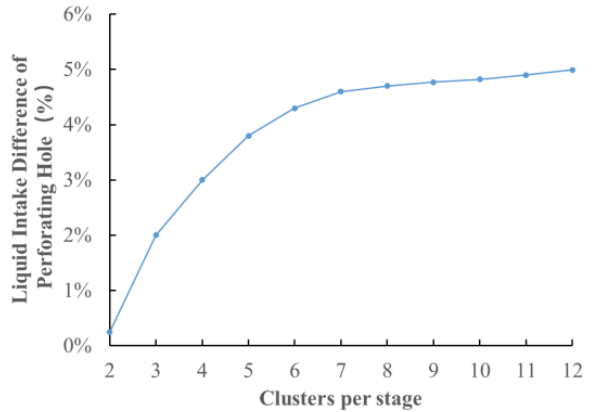
Figure 9. Liquid inflow difference of multiple clusters of fractures under different cluster numbers.